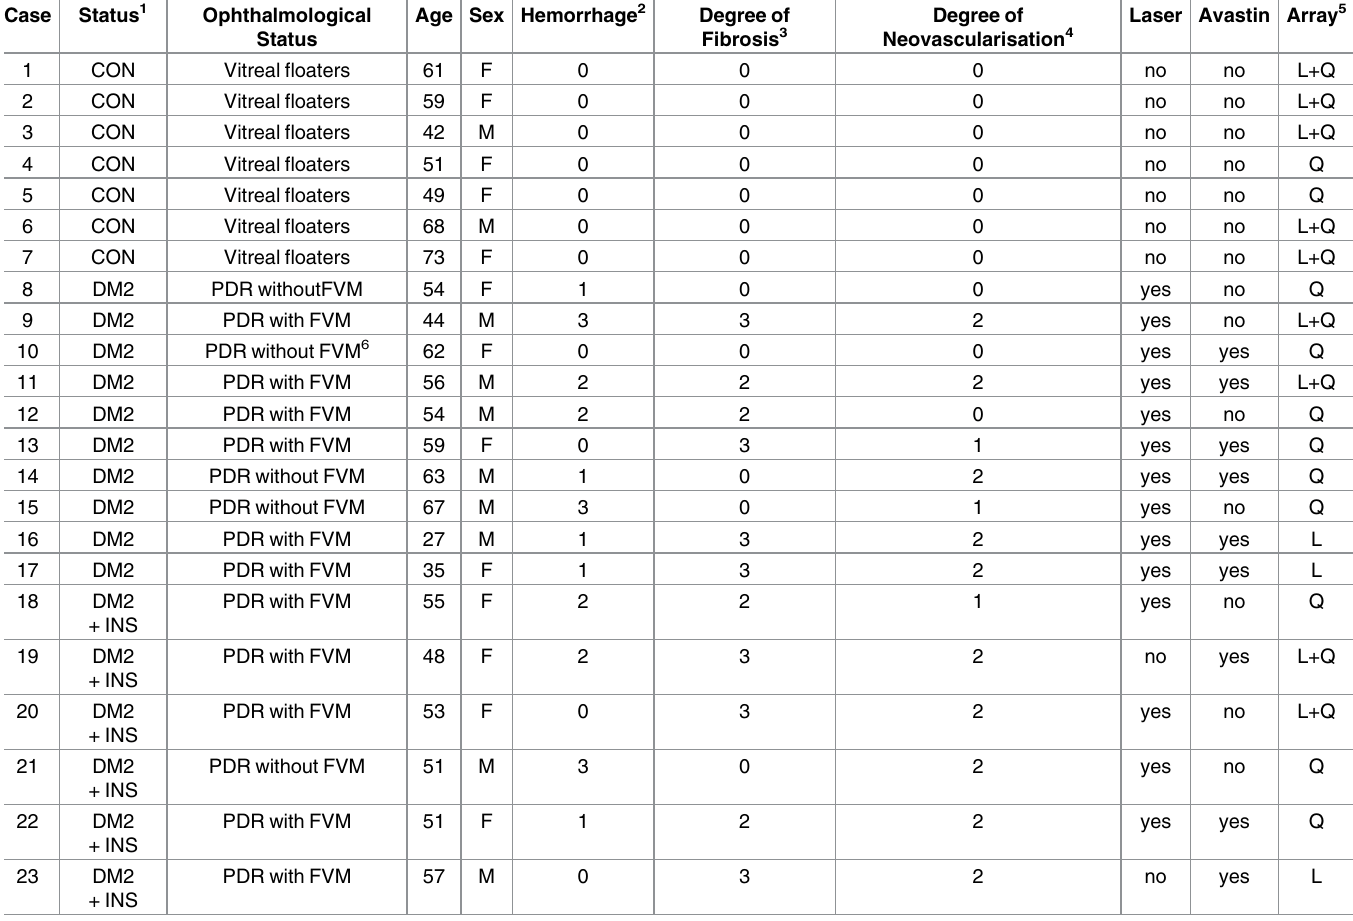
Table 1. Clinical characteristics of patients whose vitreous samples were used for protein analysis with antibody